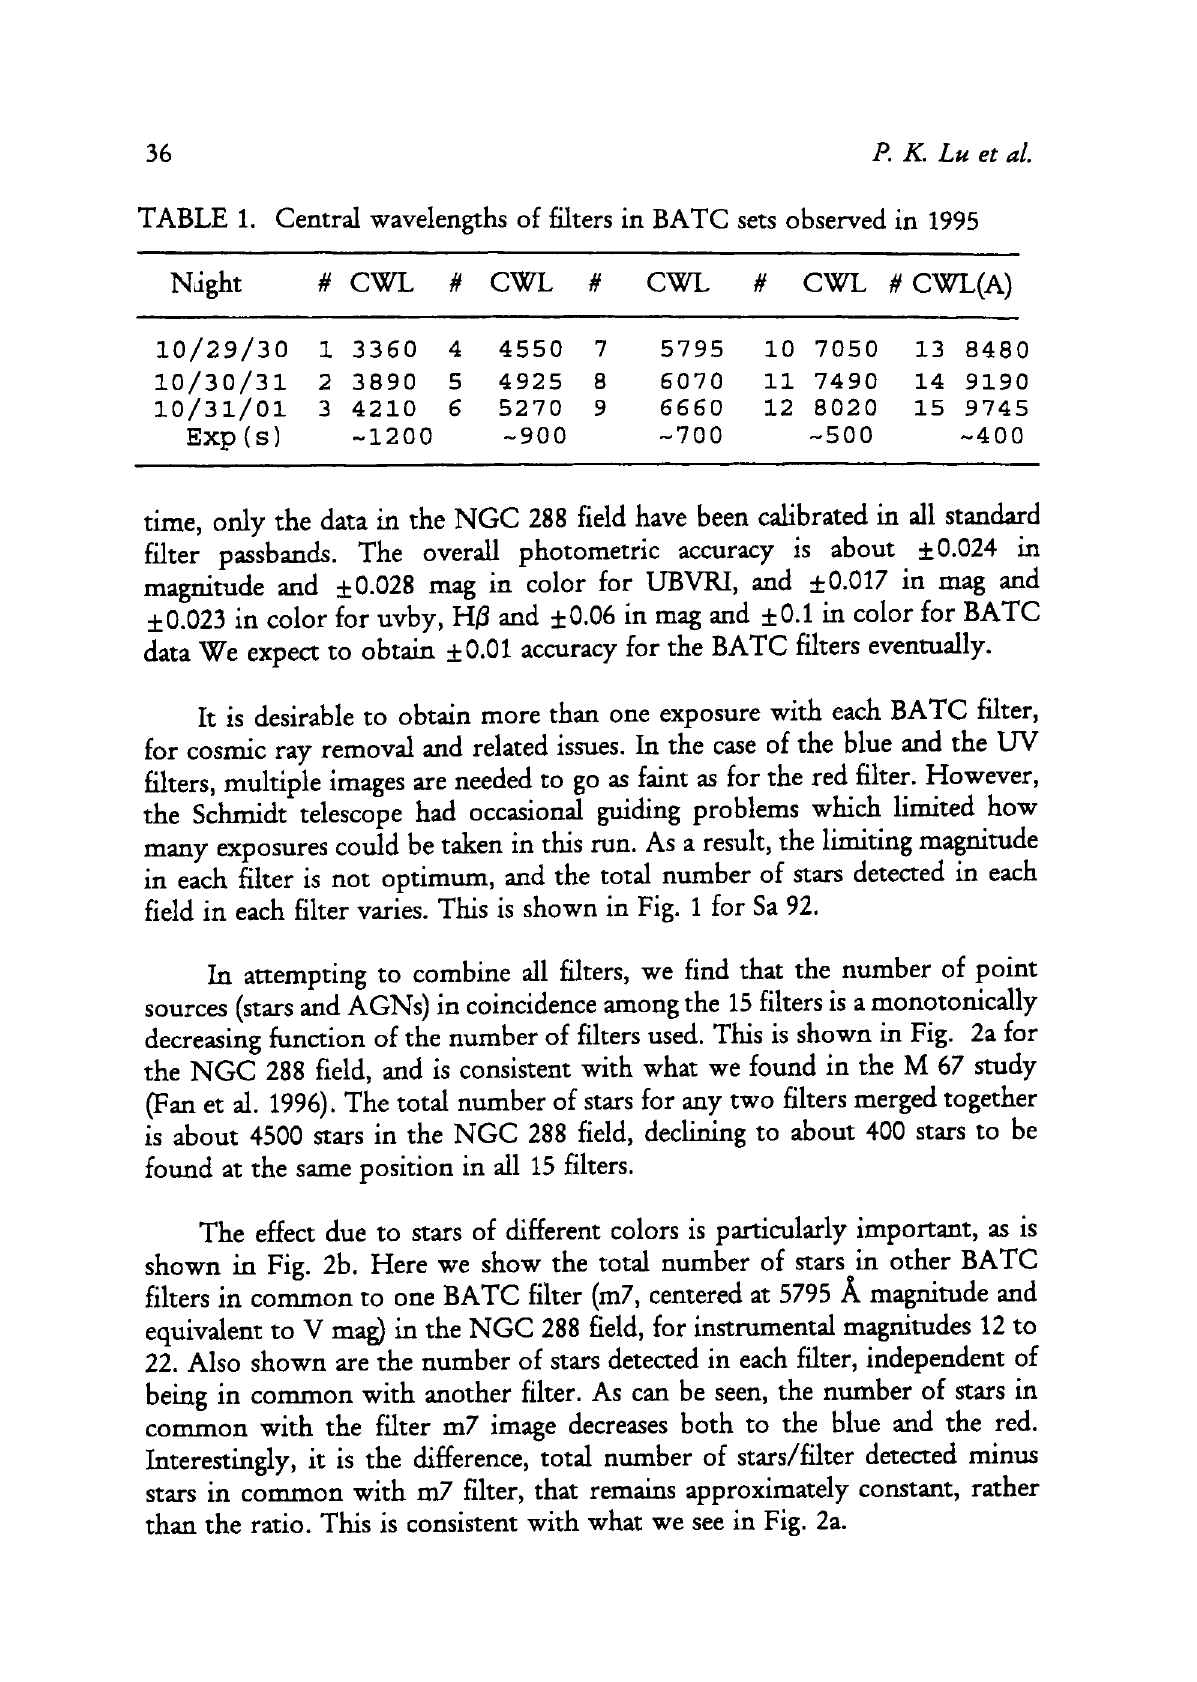
TABLE 1. Central wavelengths of filters in BATC sets observed in 1995 Night # CWL #